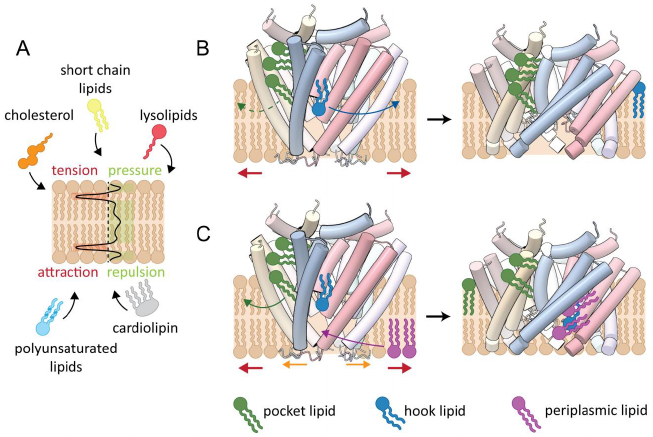
Figure 5. Lipids-move-first gating models for MscS as an implementation of the force-from-lipid principle. ( A ) The transbilayer pressure profile is shown for an ideal lipid bilayer. There is repulsion between the phosphate moieties and the fatty acid moieties, and attraction between the lipids at the onset of the fatty acid chains. This pressure profile is affected by embedded proteins and by the composition of the membrane, which allows a targeted modification of the transbilayer pressure profile. ( B , C ) For the illustration of two different gating models, MscS is shown in its closed (left, PDB 6RLD [19]) and open (right, PDB 2VV5 [40]) conformation with individually colored subunits. In the two models, increasing membrane tension (red arrows) leads to different immediate reactions involving certain lipids. For clarity, only one set of interacting lipid molecules is depicted. ( B ) Membrane tension leads to the dissociation of the hook lipid (blue arrow). This enables adjacent TM1-TM2 helix bundles to slide against each other, which is a prerequisite for channel opening. The hook lipid flips and enters the cytosolic leaflet. In this model, extrusion of pocket lipids is predominantly relevant for adopting subconducting- and adapted states (dashed green arrow). ( C ) Gating is not initiated by leaving of the hook lipid, but by lipids bound in the gaps and pockets at the cytosolic side (green arrow). Lipids from the periplasmic leaflet enter the gaps at the periplasmic side which appear upon channel opening, as the N terminal domains move outwards (orange arrows) and equilibrate with the hook lipid. This way, they prevent the exposure of the bulk water in the funnel to the lipidic surrounding.